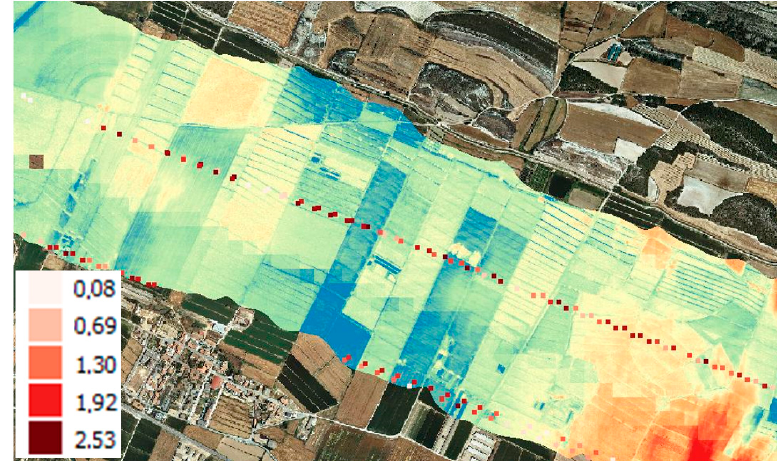
Figure 12. Roughness parameter (square dots) [-] overlaid over the SM [m 3 /m 3 ] map in the Region of Interest (ROI) (area corresponds to rectangle A in Figures 7–9).